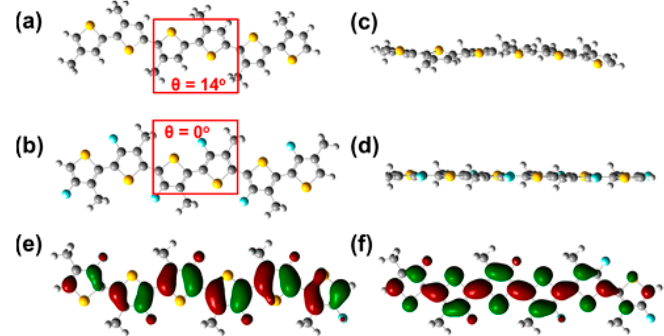
Figure 4. Top view of energy-minimized structures of a methyl-substituted hexameric ( a ) P3AT and ( b ) F-P3AT. Side view of energy-minimized structure of ( c ) a methyl-substituted P3AT and ( d ) FP3AT. HOMO ( e ) and LUMO ( f ) distributions for the energy minimized structure of F-P3AT. All calculated using DFT at the B3LYP/6.31G (d,p) level (adapted with permission from [27]; Copyright 2015 American Chemical